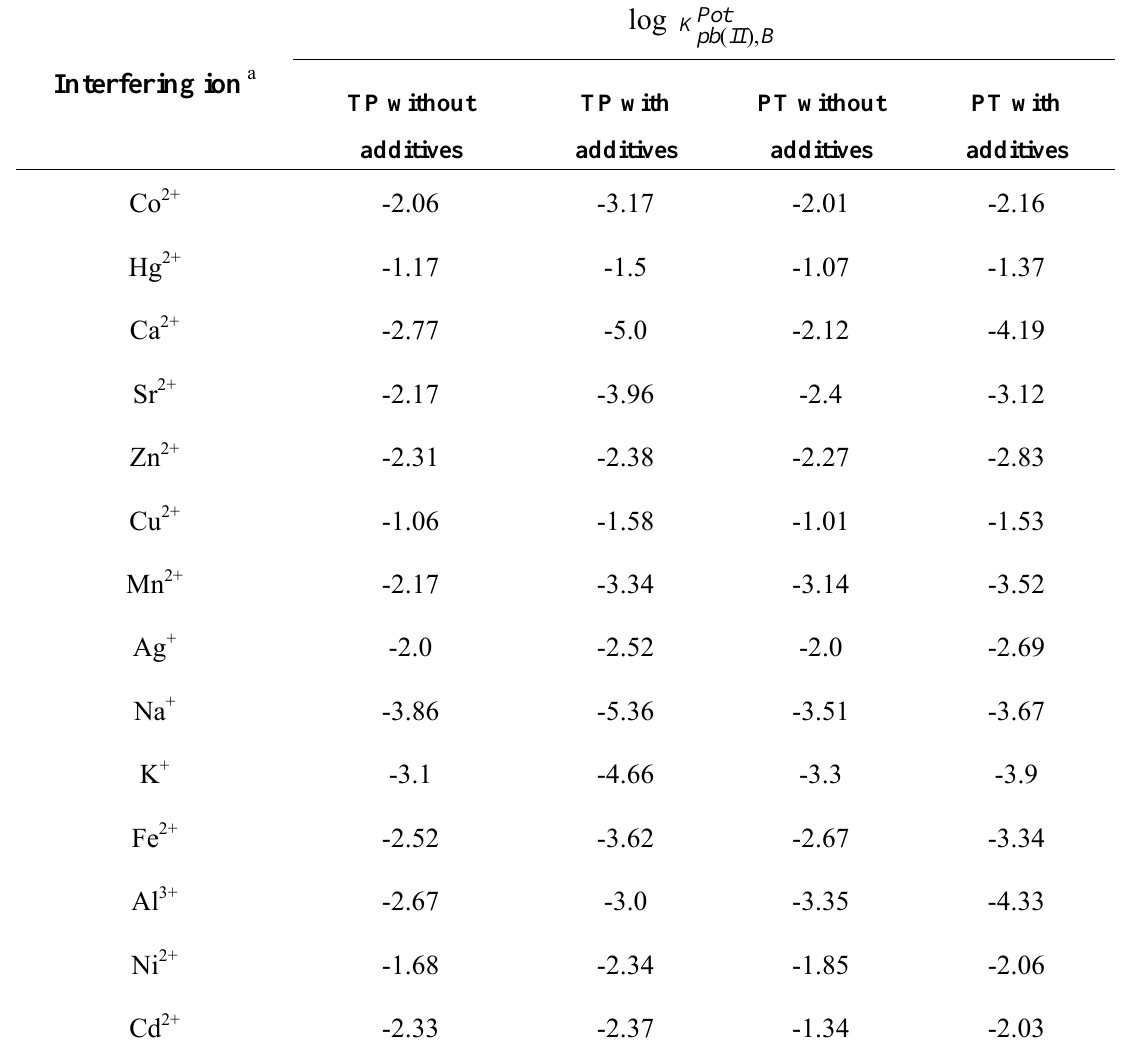
Table 3. S electivity coefficient ( Pot ionophores at 10 -3 M for both Pb 2+ and